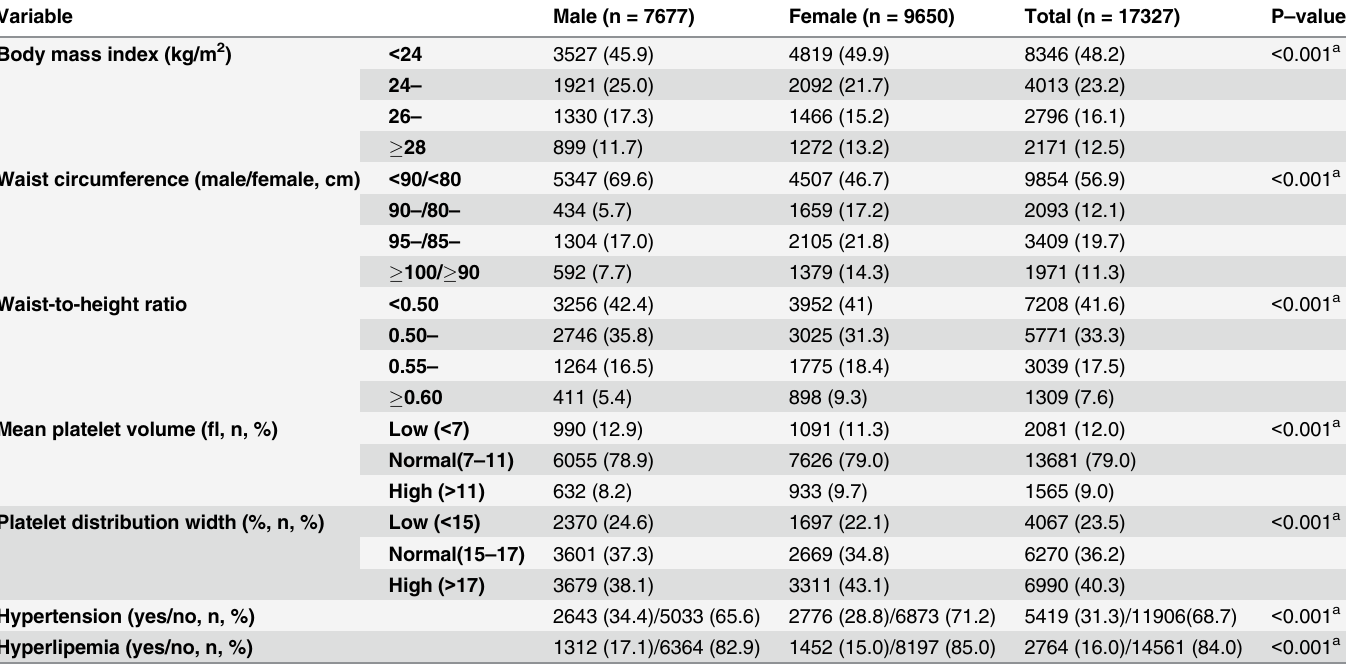
Table 2. Distributions of clinical variables of